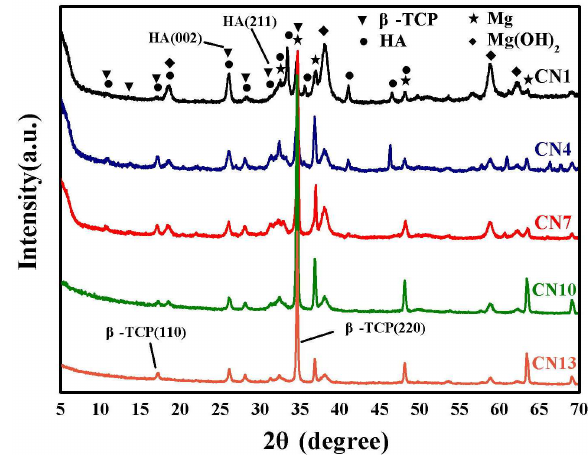
Figure 1. X-ray di ff raction (XRD) patterns of the Ca-P-coated samples prepared at di ff erent contents of Figure 1. X-ray diffraction (XRD) patterns of the Ca-P-coated samples prepared at different contents of sodium citrate. sodium